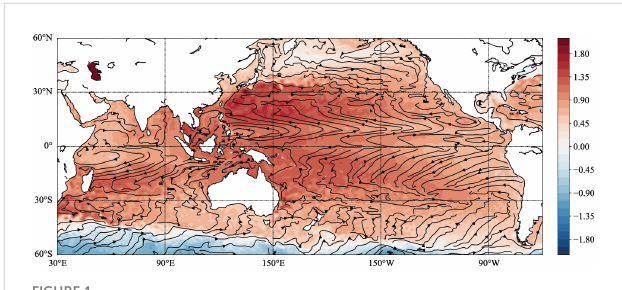
FIGURE 1 Annual mean sea surface currents (vectors, OSCAR) and sea surface height (color, AVISO) in